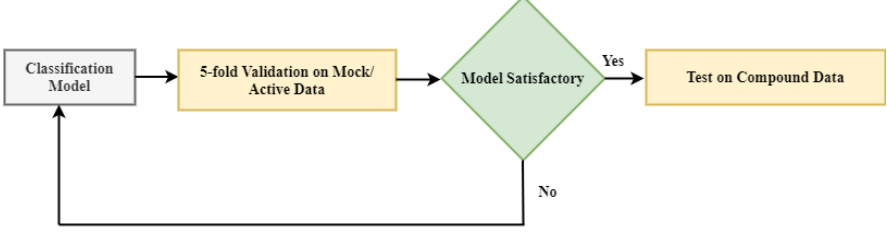
Figure 5. Simplified model test procedure based on the USFDA MAQC II protocol